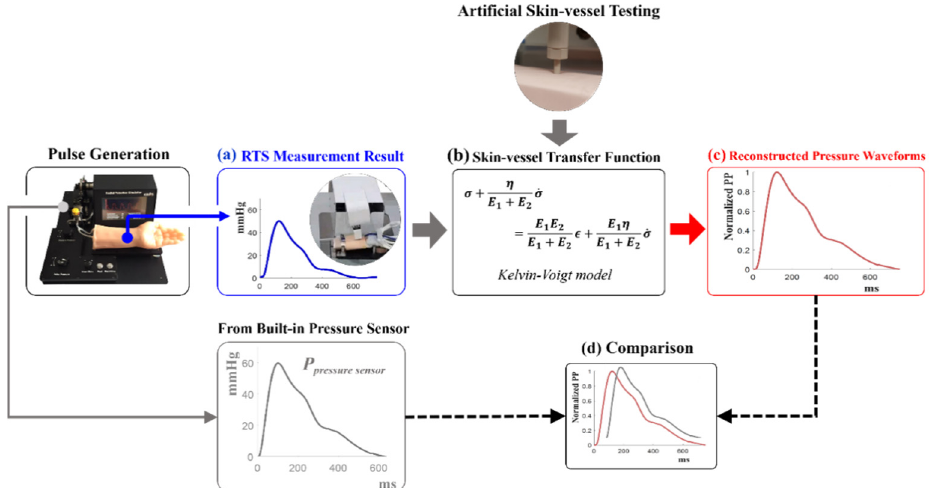
Figure 3. A flow of the overall process: ( a ) Pulse pressure waveform measured on skin above the simulator’s wrist using RTS, ( b ) skin-vessel transfer function modeling based on artificial skin and vessel mechanical testing results, ( c ) intravascular pulse pressure waveforms reconstructed from the RTS measurement results by the skin-vessel transfer function, ( d ) the comparison of the differences between the reconstructed waveforms and the pulse pressure in vessel measured by pressure sensor.